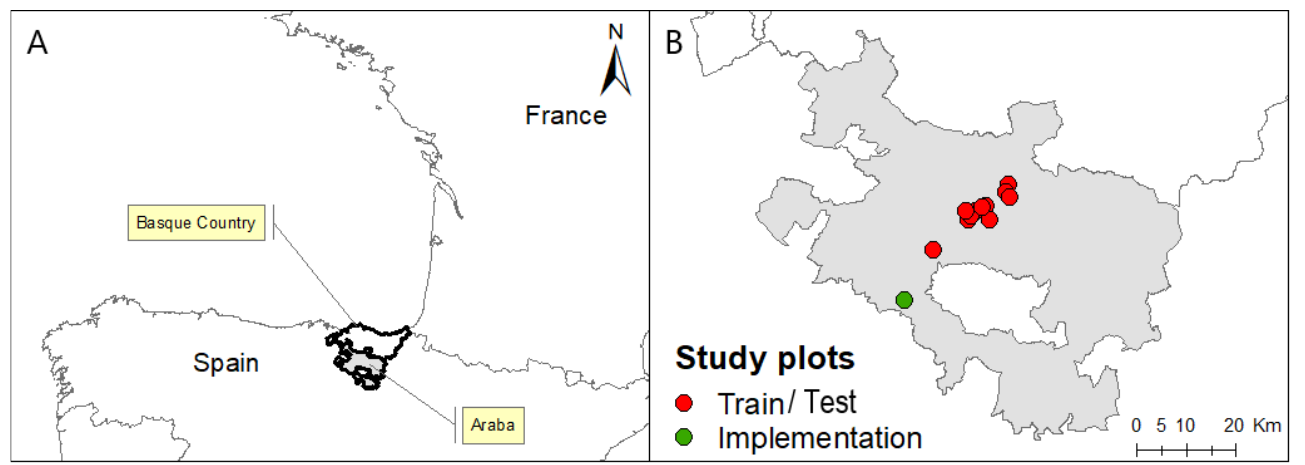
Figure 1. ( A ) General location of the province of Araba/ Á lava in Spain. ( B ) Location of 14 wheat plots. The red dots represent the plots belonging to farmer 1 used to train and test the algorithm. The green dot represents the implementation plot (farmer 2).